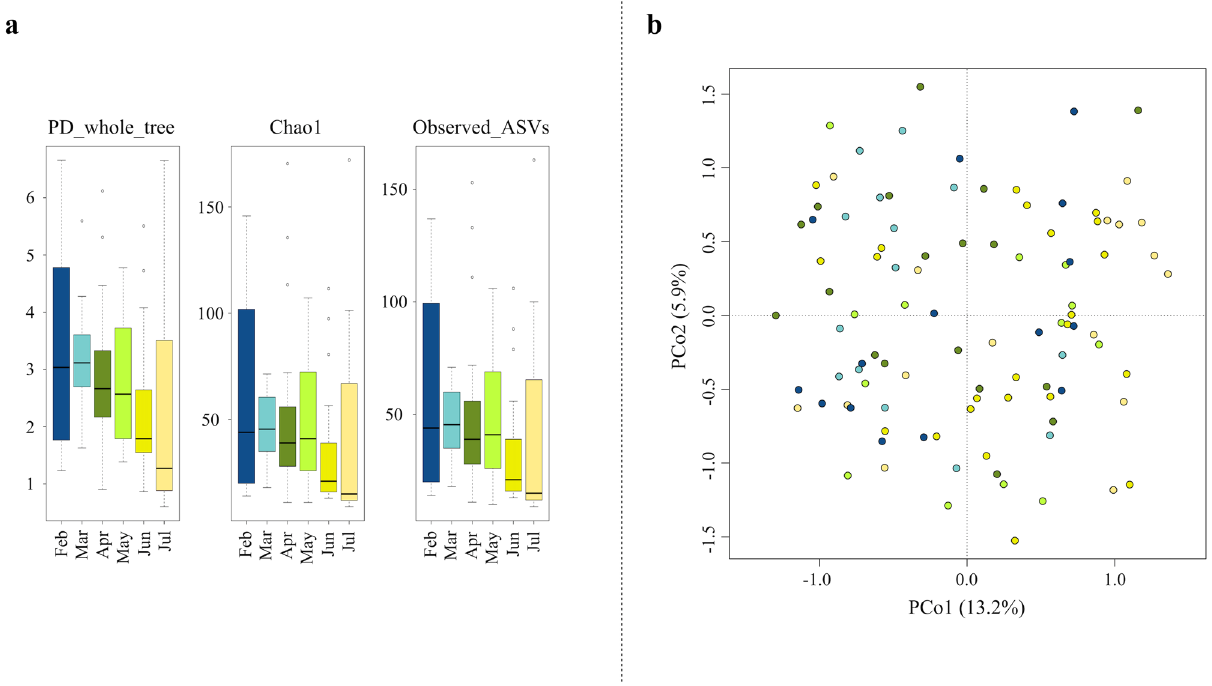
Figure 2. AM alpha and beta diversity throughout the sampling period. ( a ) Box-and-whiskers distribution of Faith’s Phylogenetic Diversity (PD_whole_tree), Chao1 index for microbial richness and number of observed ASVs, for each month of sampling. The data show a trend towards reduced microbial richness from winter to summer, although the differences did not reach statistical significance (Kruskal–Wallis test, FDR-corrected p-value > 0.05). ( b ) Principal Coordinates Analysis (PCoA) based on unweighted UniFrac distances between AM profiles, showing separation by sampling month (permutation test with pseudo-F ratio, p-value = 0.012) (same colour code as in panel A). The first and second principal components (PCo1 and PCo2) are plotted and the percentage of variance in the dataset explained by each axis is